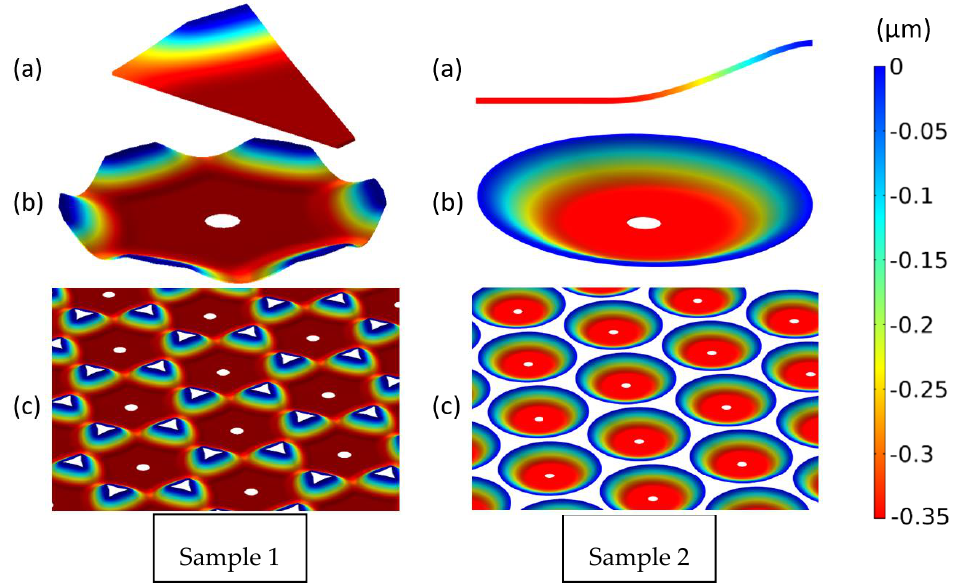
Figure 10. The deformation at 40 V of the sample 1 and sample 2 mirrors, ( a ) the modeled and simulated geometry, ( b ) a single mirror, and ( c ) an array of mirrors.